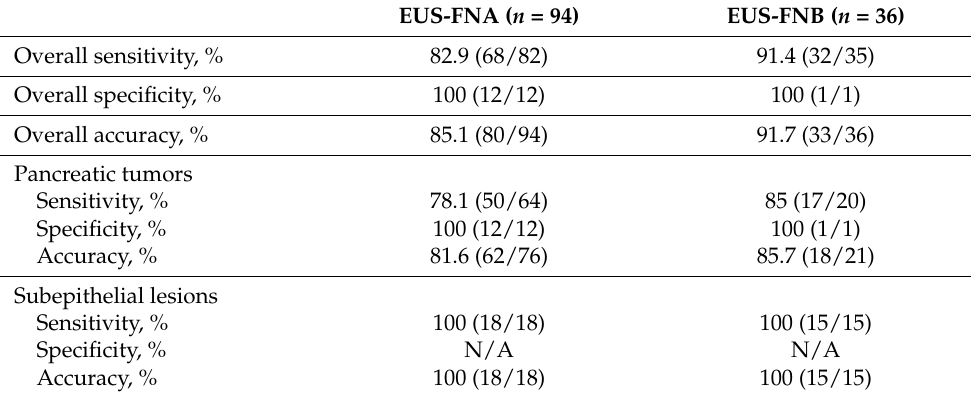
Table 4. The sensitivity, specificity and accuracy of EUS-FNA and EUS-FNB.